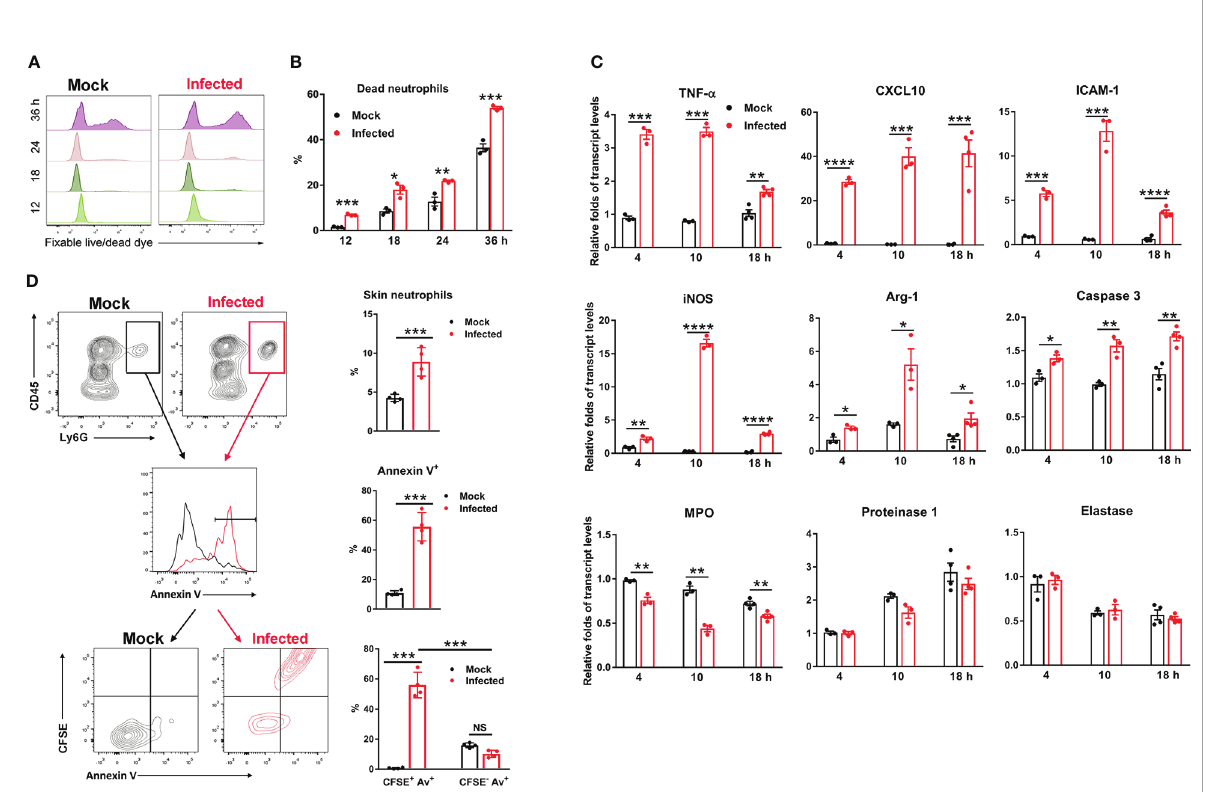
FIGURE 2 Ot infection triggered neutrophil activation and apoptosis. Bone marrow-derived neutrophils were prepared by using anti-Ly6G magnetic beads. The purity of BM neutrophils is 96% based on fl ow cytometric analysis. Cells were infected with Ot (MOI: 10) in vitro and harvested at indicated time-points. (A) The viability of cells was determined by using fi xable live/dead viability dye. (B) The percentages of dead neutrophils at various timepoints were presented based on the fl ow cytometric analysis. (C) Cells were cultured in vitro , infected with Ot and harvested at 4, 10 and 18 hours (h) post-infection. The transcript levels of activation (TNF- a , CXCL10, ICAM-1, iNOS and Arg-1), apoptosis (Caspase-3) and granules (MPO, Proteinase-1 and Elastase) were detected using qRT-PCR. (D) B6 mice (n=4/group) were i.d. infected with CFSE-labeled Ot (4×10 3 FFU) in the ears. Mock mice (n=4/group) were i.d. injected with PBS as a control. Skin tissues were harvested at 18 h, digested by collagenase for preparation of a single cell suspension, and then analyzed by fl ow cytometry. Neutrophils from mock (black) and infected (red) groups were fi rst gated as CD45 + Ly6G + cells (left panel), and quanti fi ed (right panel). Neutrophils were further sorted for Annexin V expression on the cell surface (left panel), and quanti fi ed (right panel). Finally, neutrophils were sorted by CFSE expression ( Ot -infected) and Annexin V expression (apoptosis) simultaneously (left panel), and quanti fi ed (right panel). Values are shown as mean ± SEM from single experiments and are representative of two independent experiments. A two-tailed Student ’ s t-test was used for the comparison of two groups. *, p <0.05; **, p <0.01; ***, p < 0.001; ****, p <